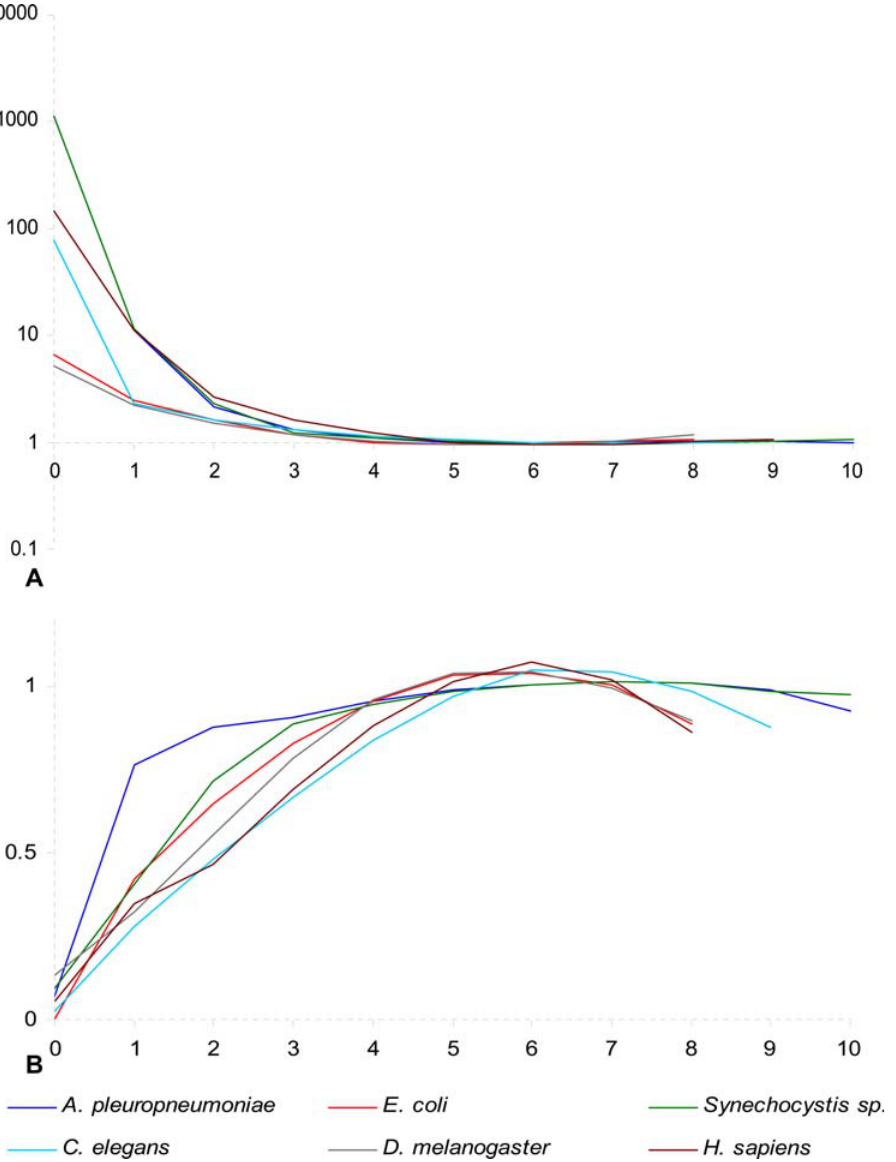
Figure 5. Ratio of the observed to the expected number of several pro- and eukaryotic oligonucleotides in their respective genome/ chromosome. X-axis: Mismatch load. A : Sequences genomically overrepresented. B : Sequences genomically underrepresented. The sequences are the same as in Tables 6 and 7.